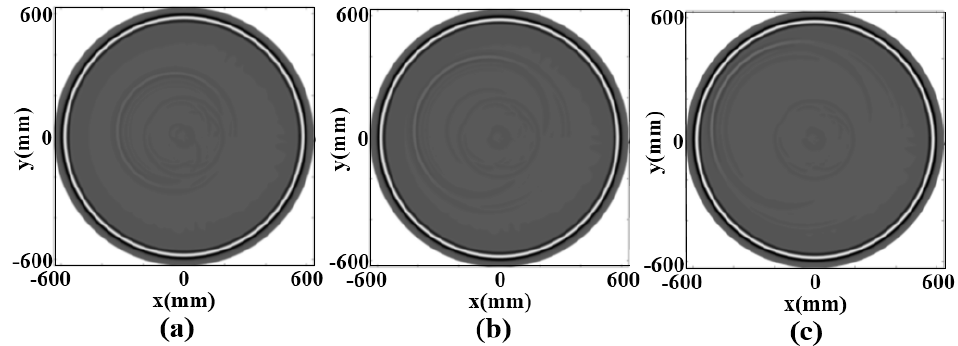
Figure 8. The simulation result of cavities at different thickness; ( a ) The distance s between the cavity center and the interface was 350 mm ; ( b ) The distance s between the cavity center and the interface was 250 mm ; ( c ) The distance s between the cavity center and the interface was 150 mm .